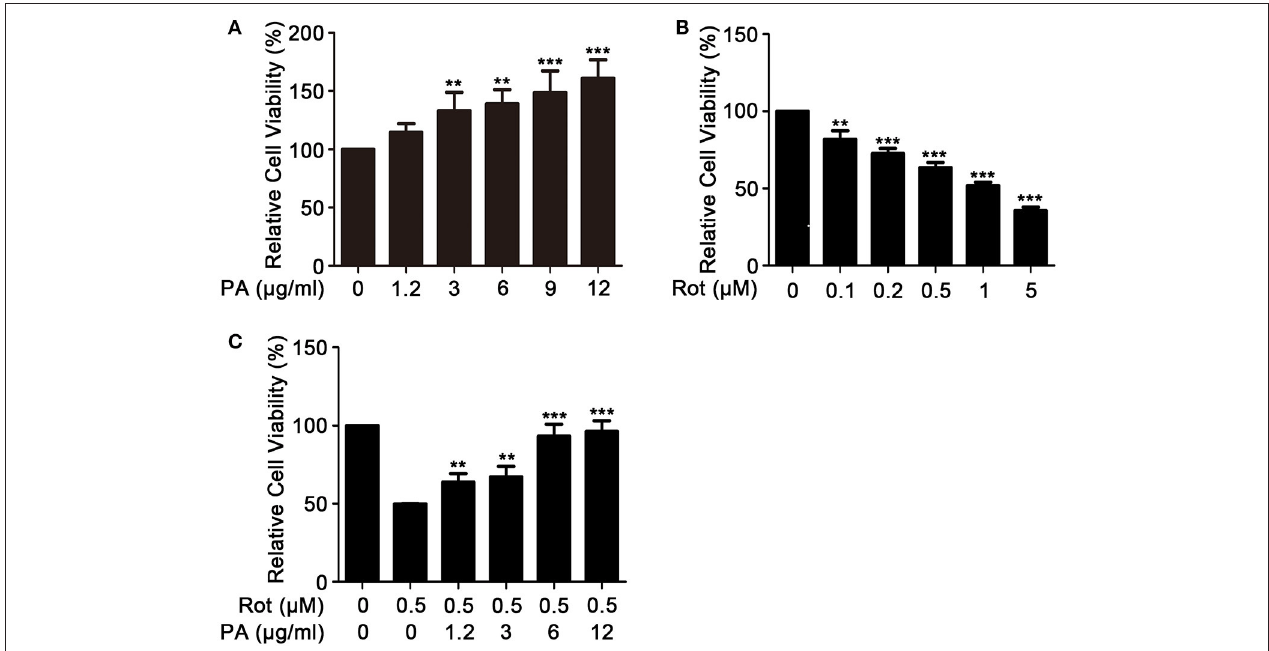
FIGURE 1 | Effects of PA and rotenone on cell viability of SH-SY5Y cells. Cells were incubated with various concentrations of PA (A) , Rotenone (B) for 24h, or PA plus Rotenone (C) for 36h. Cell viability was determined by MTT assay. Data are from experiments performed in triplicate and repeated 3 times. ** P < 0.01, *** P < 0.001, compared with rotenone-treated